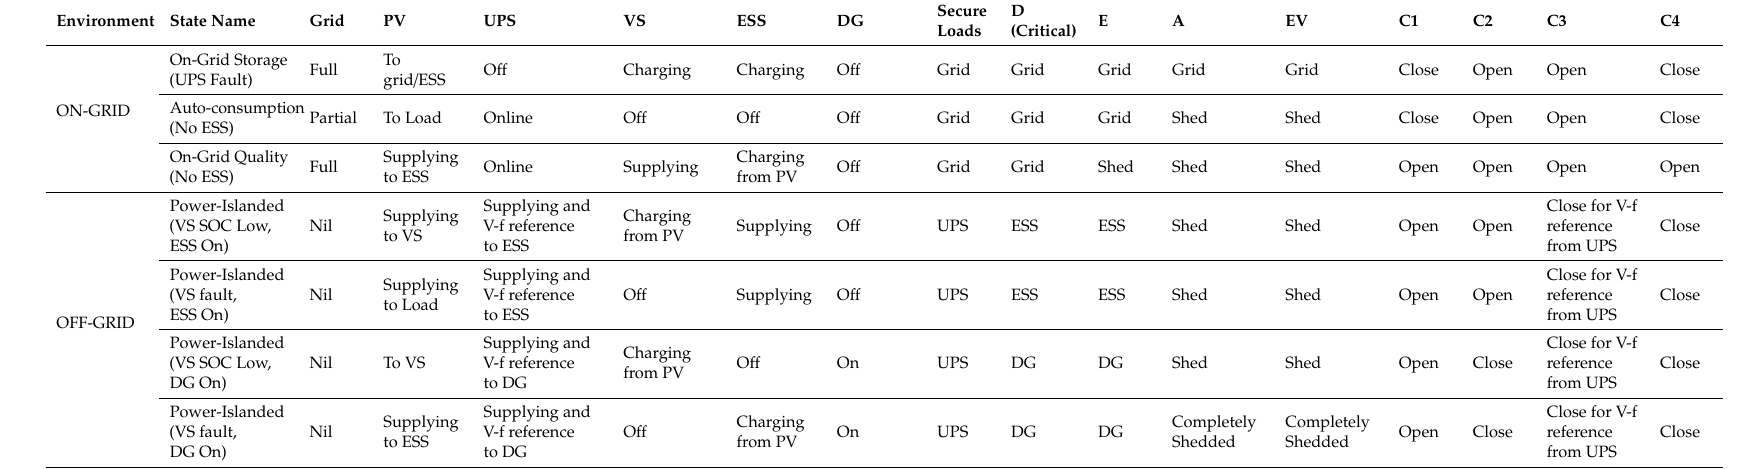
Table 3. Sub-states of defined in the microgrid